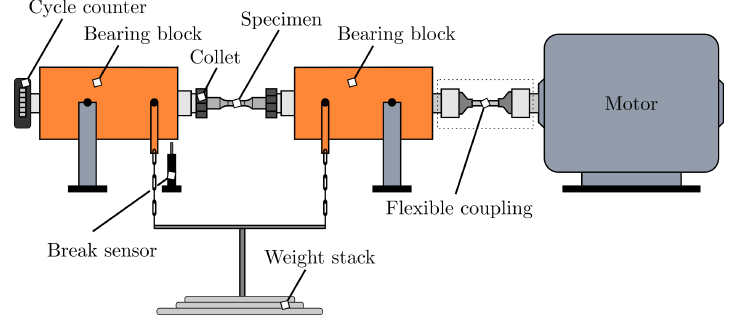
Figure 2. Schematic illustration of the R.R. Moore rotating bending fatigue